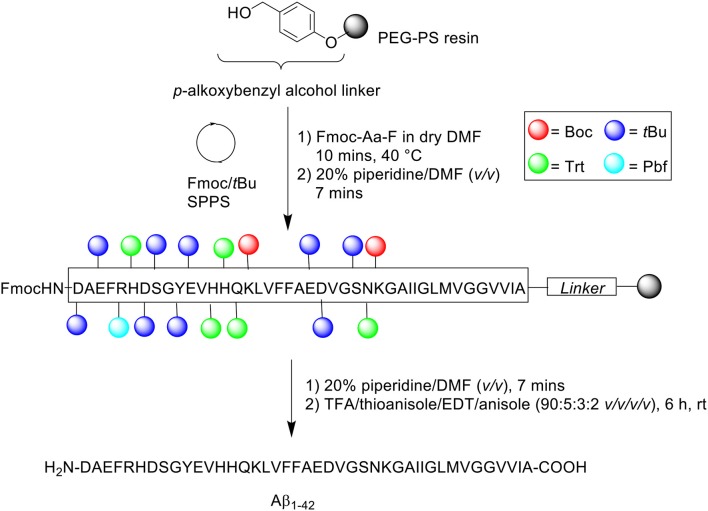
Aβ1−42 synthesized using preformed Fmoc-Aa-F by Milton et al. (1997).